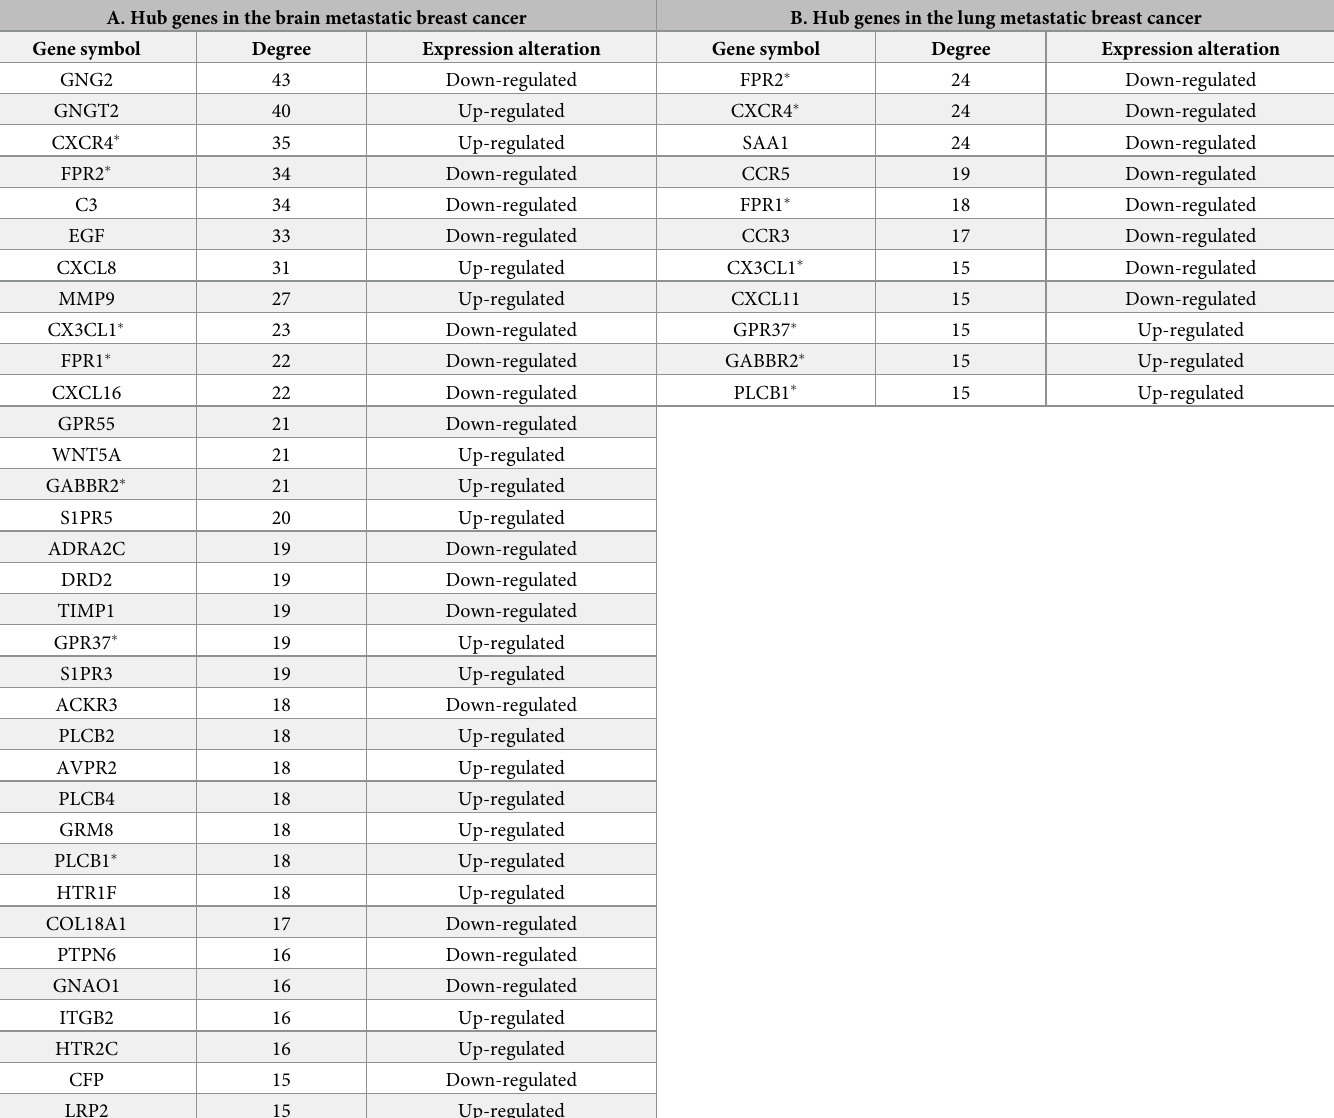
Table 1. Nodes with the highest degree of connectivity in the PPI network (degree � 15). (A) Hub nodes extracted from the brain metastatic breast cancer PPI network. (B) Hub nodes obtained from the lung metastatic breast cancer PPI